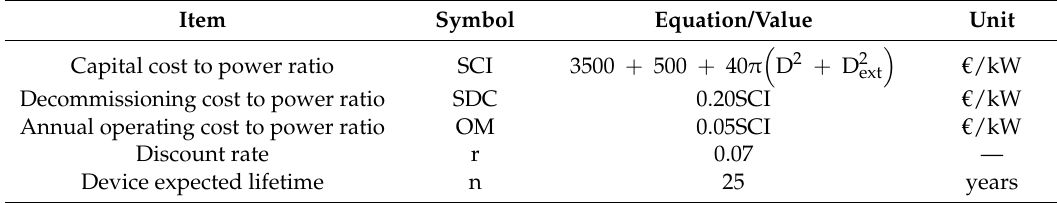
Table 5. Main data for LCoE